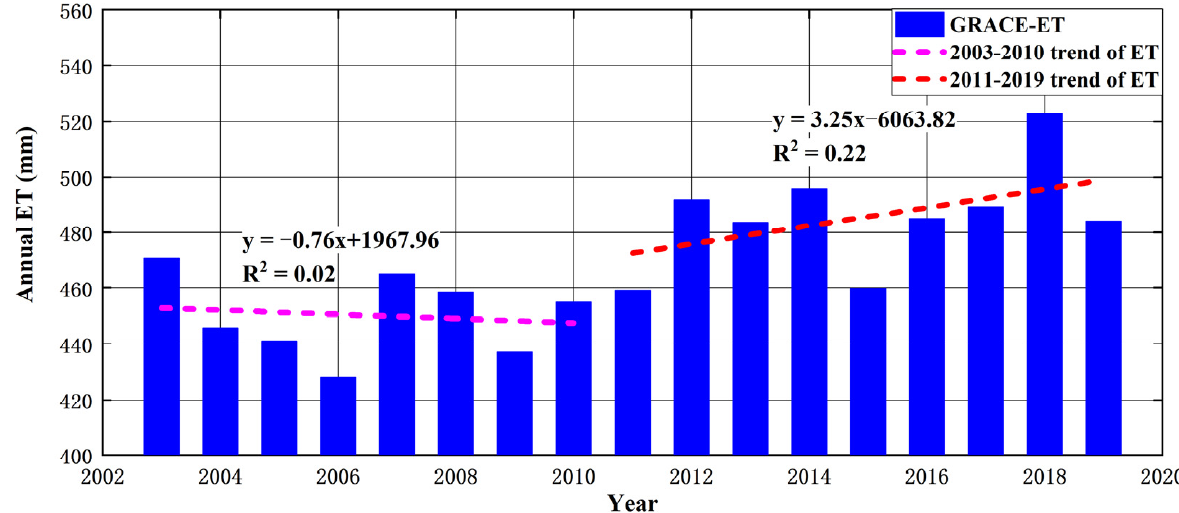
Figure 9. Time series of evapotranspiration (ET) calculated by Gravity Recovery and Climate Experiment (GRACE)/GRACE Follow-On (GRACE/GRACE-FO) in the Yellow River Basin from 2003 to 2019. GRACE—Gravity Recovery and Climate Experiment. Table 1. Annual mean precipitation and annual cumulative evapotranspiration (ET) of different products in different periods in the Yellow River Basin (unit: mm). GRACE—Gravity Recovery and Climate Experiment; GLEAM—Global Land Evaporation Amsterdam Model; GLDAS—Global Land Data Assimilation Systems.